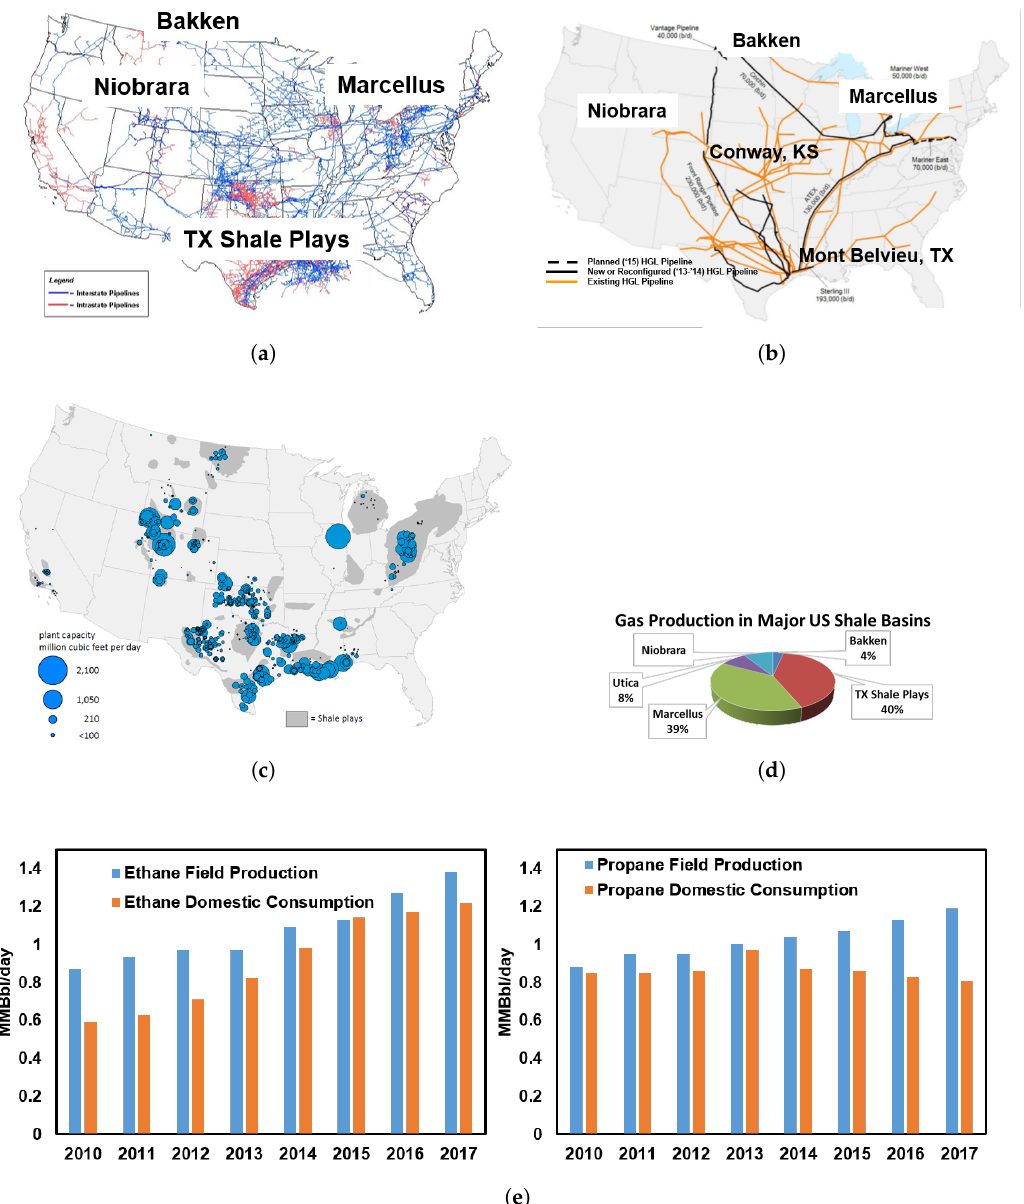
Figure 1. ( a ) United States gas transportation systems network. TX Shale Plays include Barnett, Eagle Ford, and Permian basins. Adapted from the Energy Information Agency (EIA) [4]. ( b ) Existing United States hydrocarbon gas liquid (HGL) pipeline network. Adapted from the EIA [5,6]. ( c ) Existing United States gas processing capacity. Adapted from the EIA [5,6]. ( d ) Distribution of shale gas production in the United States based on the shale basins. TX Shale Plays include Barnett, Eagle Ford, and Permian basins [4]. ( e ) United States propane and ethane production and consumption from 2010 to 2017